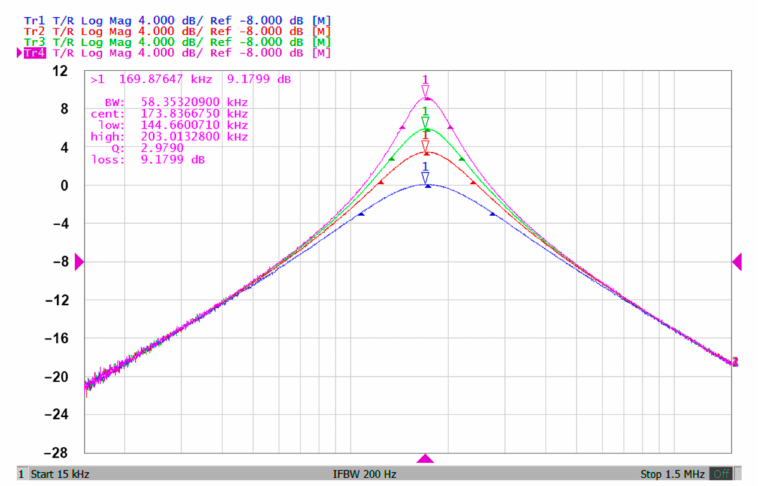
Figure 34. The measured magnitude responses of the V BP5 with different Q values by varying R 4 while keeping f o .